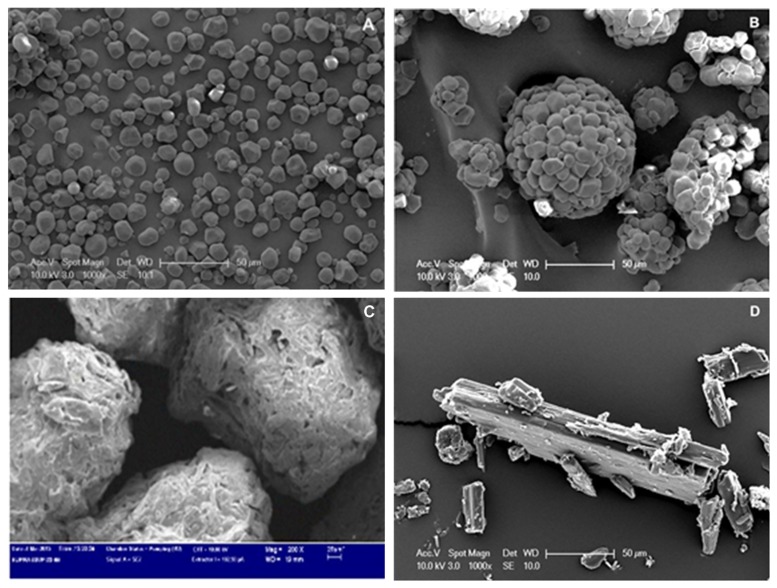
Scanning electron microscopy micrographs at 1000 times magnification of (a) starch (b) pregelatinised starch (c) MCC and (d) ergocalciferol.